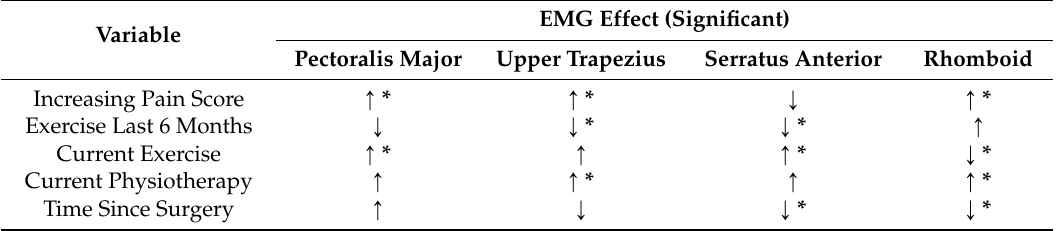
Table 5. Significant factors affecting muscle activity on the affected shoulder as compared to the unaffected